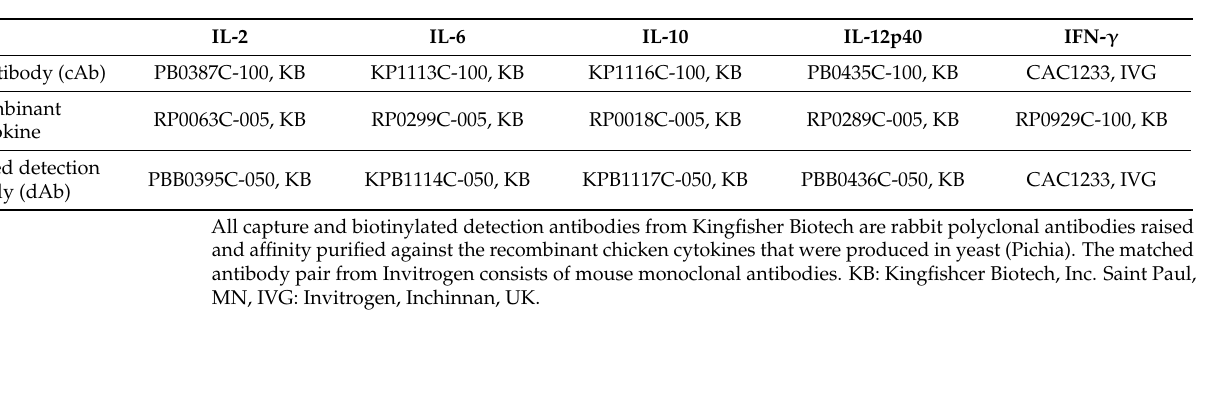
Table 1. Reagents used for the chicken cytokine capture ELISAs and their catalog